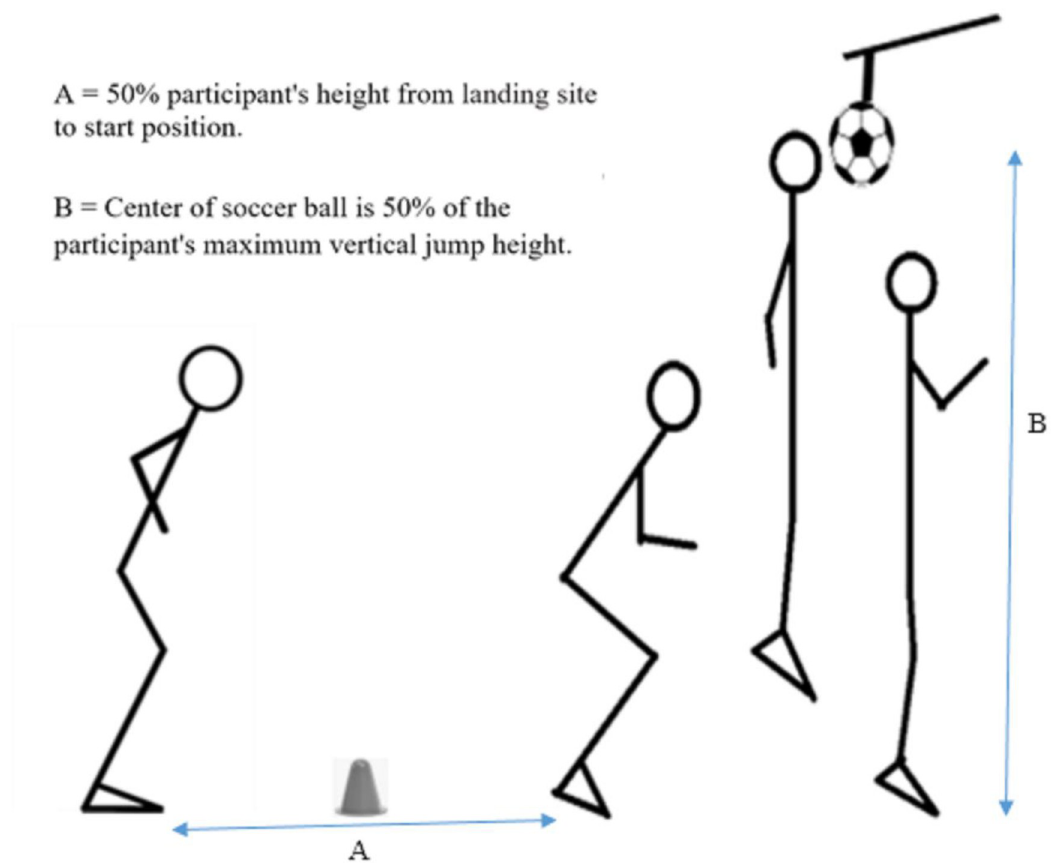
Fig 2. Soccer-specific jump-landing